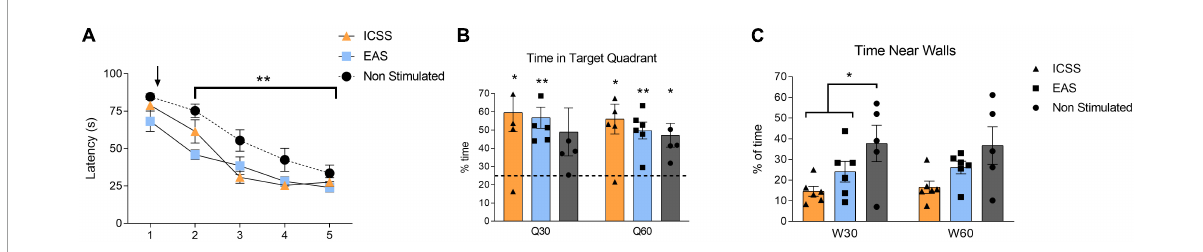
FIGURE12 Effects of administration type (self-administered or experimenter-administered) on the acquisition and retention of a spatial task in the Morris Water Maze (MWM). (A) Mean escape latencies ( ± SE) of intracranial electrical self-stimulation (ICSS), experimenter-administered stimulation (EAS), and non-stimulated groups for the five sessions of the acquisition phase. Black arrow indicates the start of the treatment administration (self-administered, experimenter-administered, or non-stimualted). Both ICSS and EAS groups showed a significant statistically lower escape latencies compared to the non-stimulated group once the treatment had begun (S2–S5). ** P ≤ 0.01. (B) Time spent in the target quadrant ( ± SE) during the retention test for the first half of the test (Q30) and the total of the test (Q60). Note that the chance level (25%) is shown in the graph as a dashed horizontal line. (C) Time spent near walls ( ± SE) during the retention test for the first half of the test (W30) and the total of the test (W60). Significant differences are shown as * P ≤ 0.05, ** P ≤